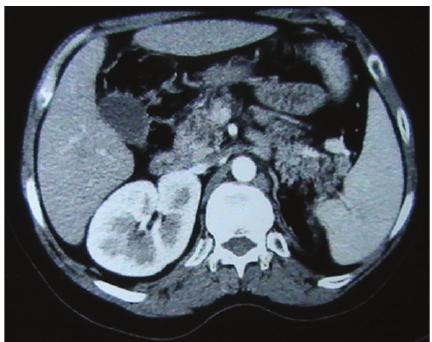
Figure 6: Abdominal CT: unilateral left renal aplasia.